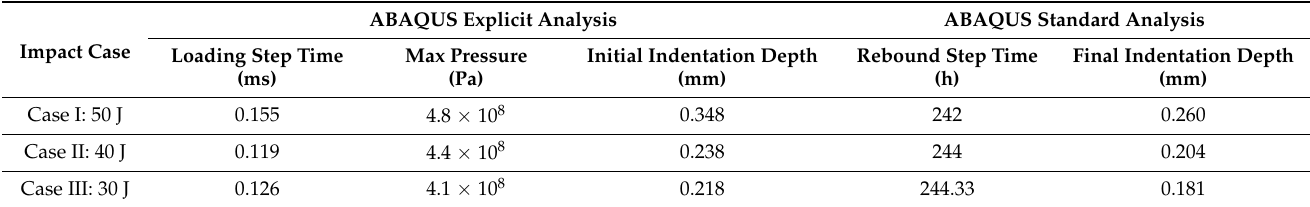
Table 8. Summary of both types of simulation for each impact